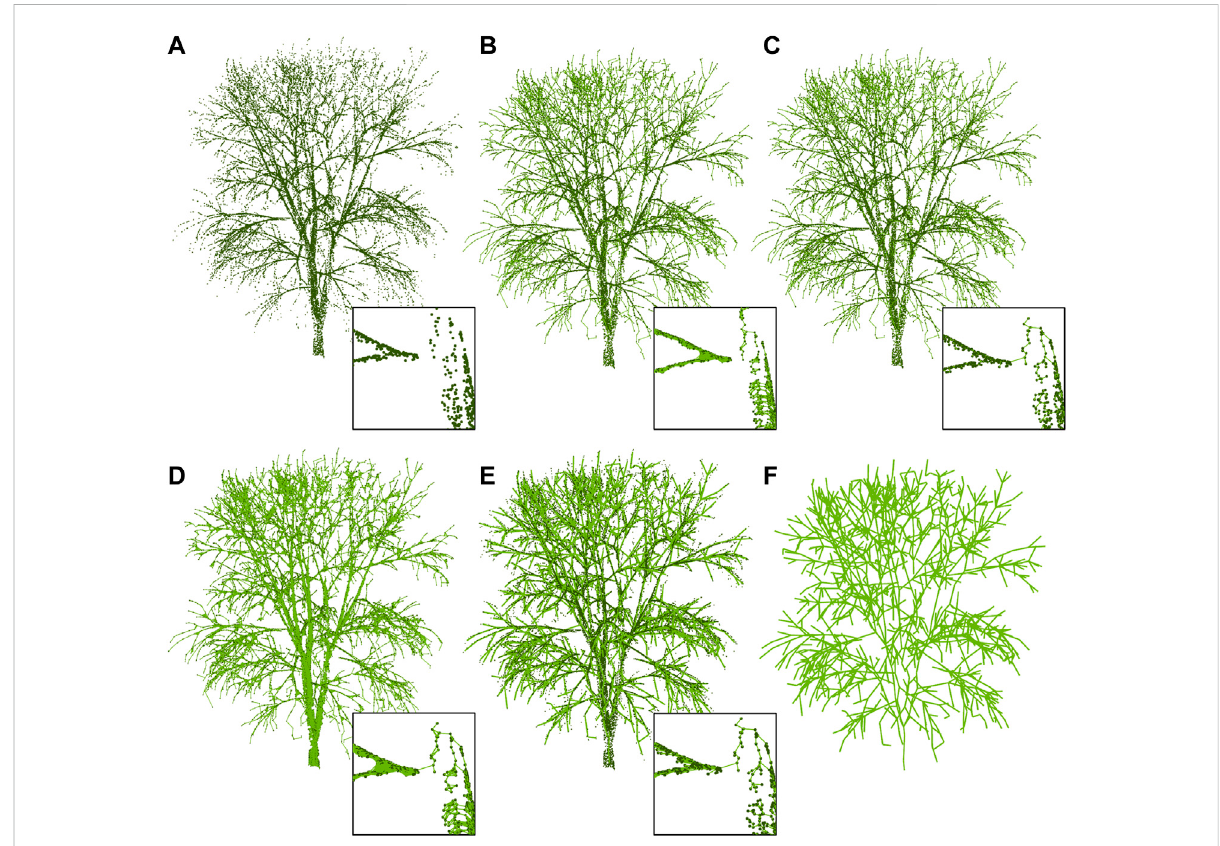
FIGURE 4 Resultsofthestages (A – F) thatarepartofourmethodologyforasinglesynthetictree.IntheMSTstage,branchlinksnotdetectedintheradius- search are